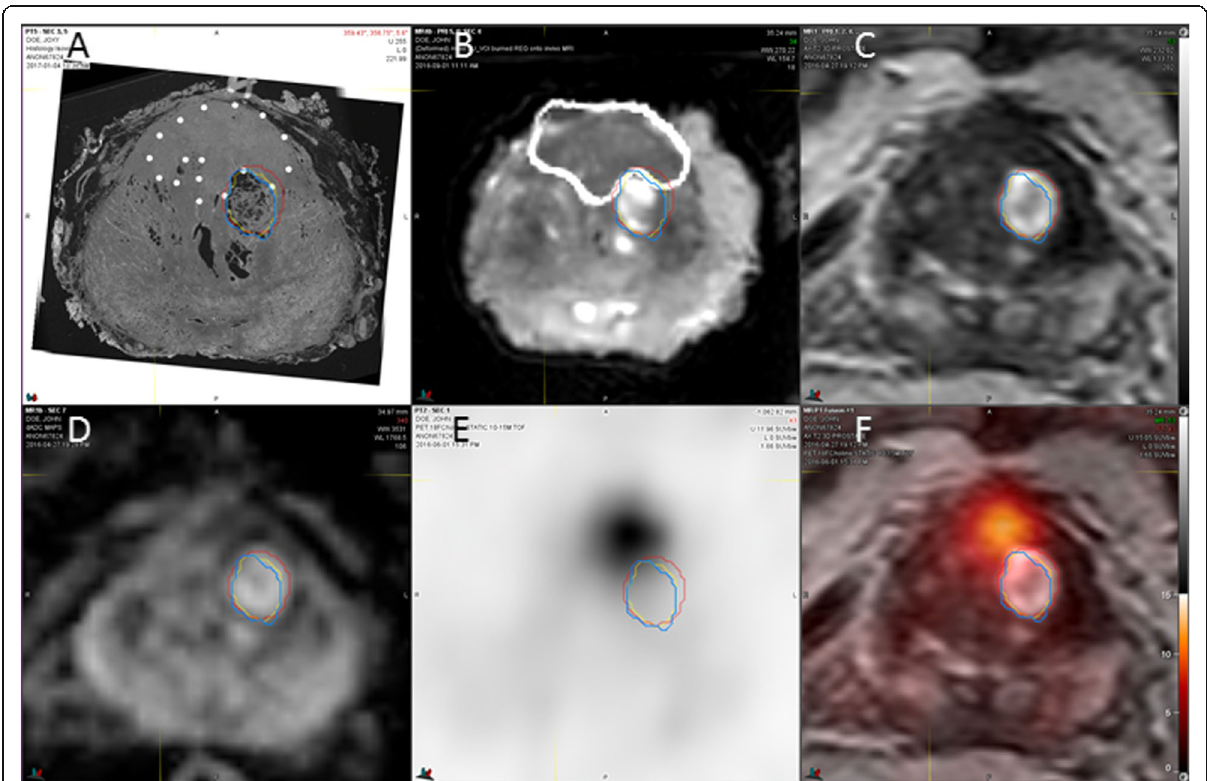
Fig. 3 Determination of registration accuracy. Registered transaxial HE histology ( a ), specimen 3D T2W MRI ( b ), in vivo 3D 2TW MRI ( c ), ADC ( d ), 18 F-choline PET ( e ), and fusion PET/MRI ( f ) are shown (SUV range 0 – 15). Contours of a BPH nodule obtained from histology (blue), ex vivo mold MRI (yellow), and in vivo MRI (red) are displayed on corresponding slices. Also, contours of a Gleason 3+4 adenocarcinoma in the anterior gland are shown on histology ( a ) and ex vivo corresponding specimen MRI ( b